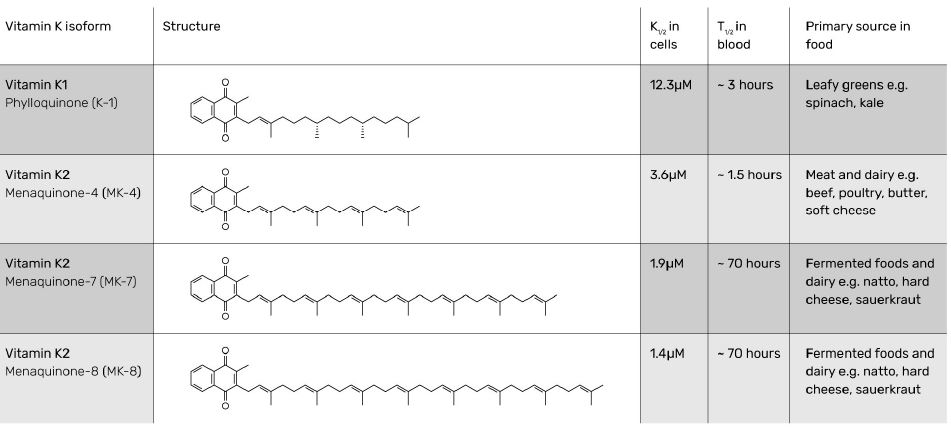
Figure 1. Name, structure, K1 / 2, T1 / 2, and main sources of vitamin K1 and major vitamin K2 isoforms [25].